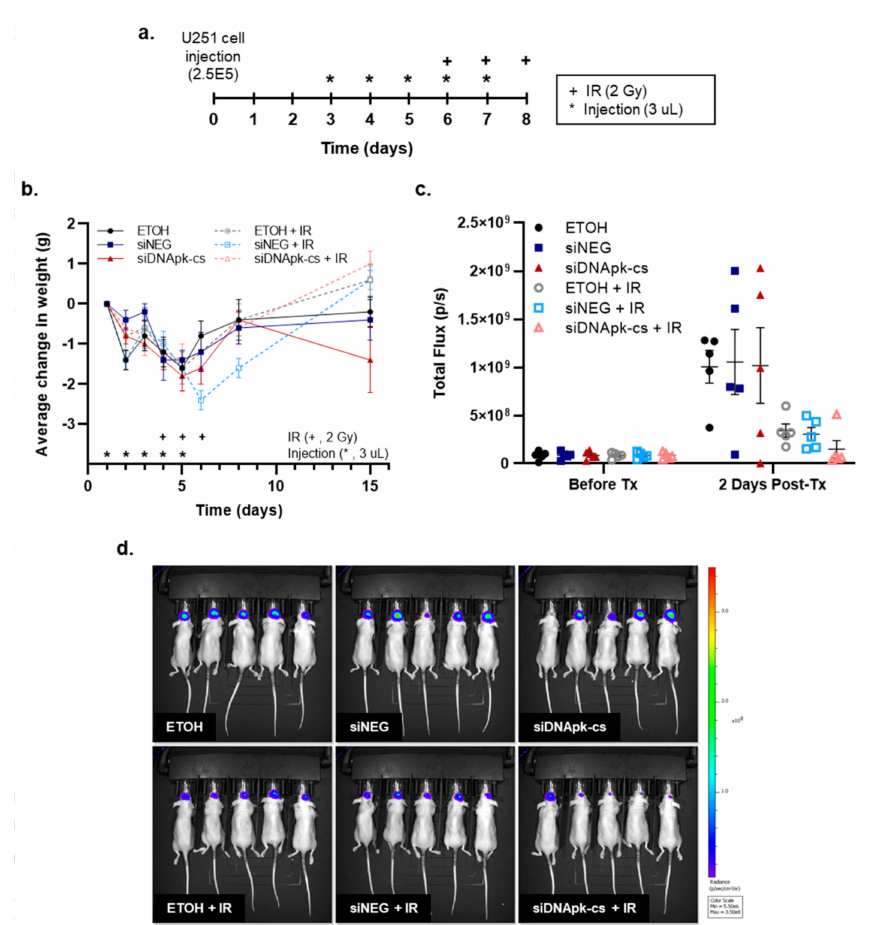
Figure 5. In vivo evaluation of treatment with intratumorally injected RGD-PEG labeled ECO nanoparticles. ( a ) Experimental schedule. ( b ) Average change in animal weight with respect